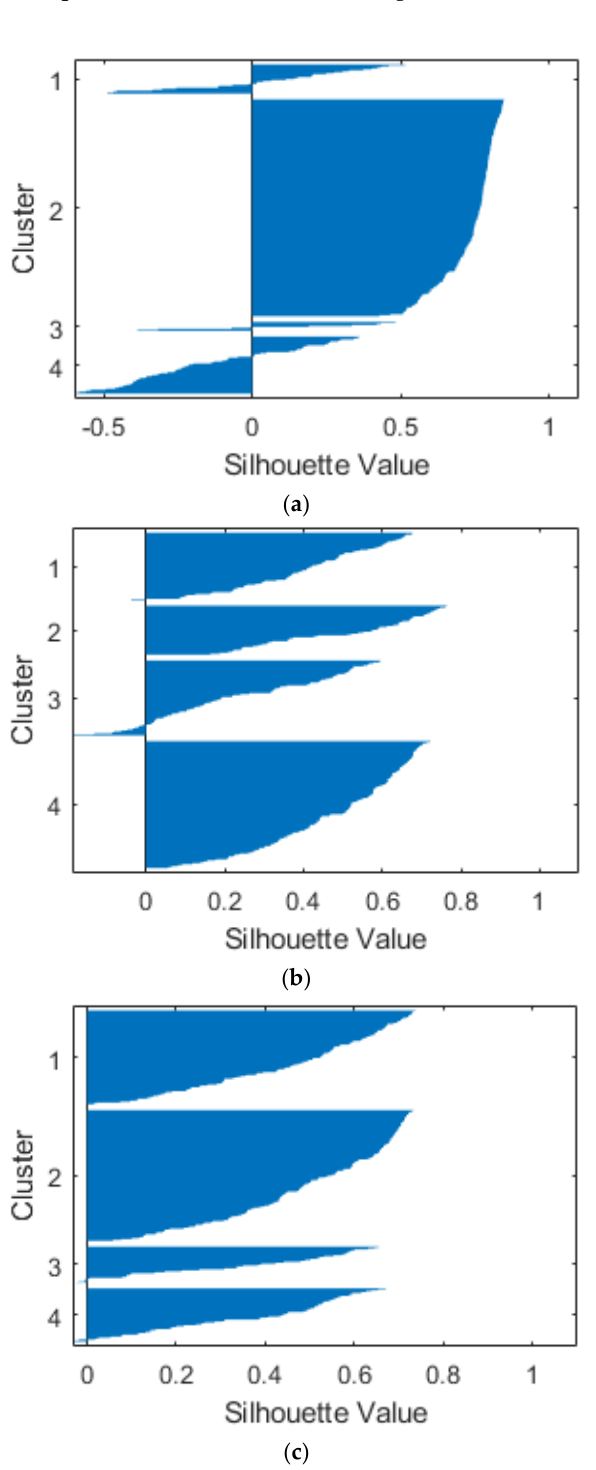
Figure 9. Silhouette for different metrics: squared Eculidean ( a ), cosine ( b ), and correlation ( c ).